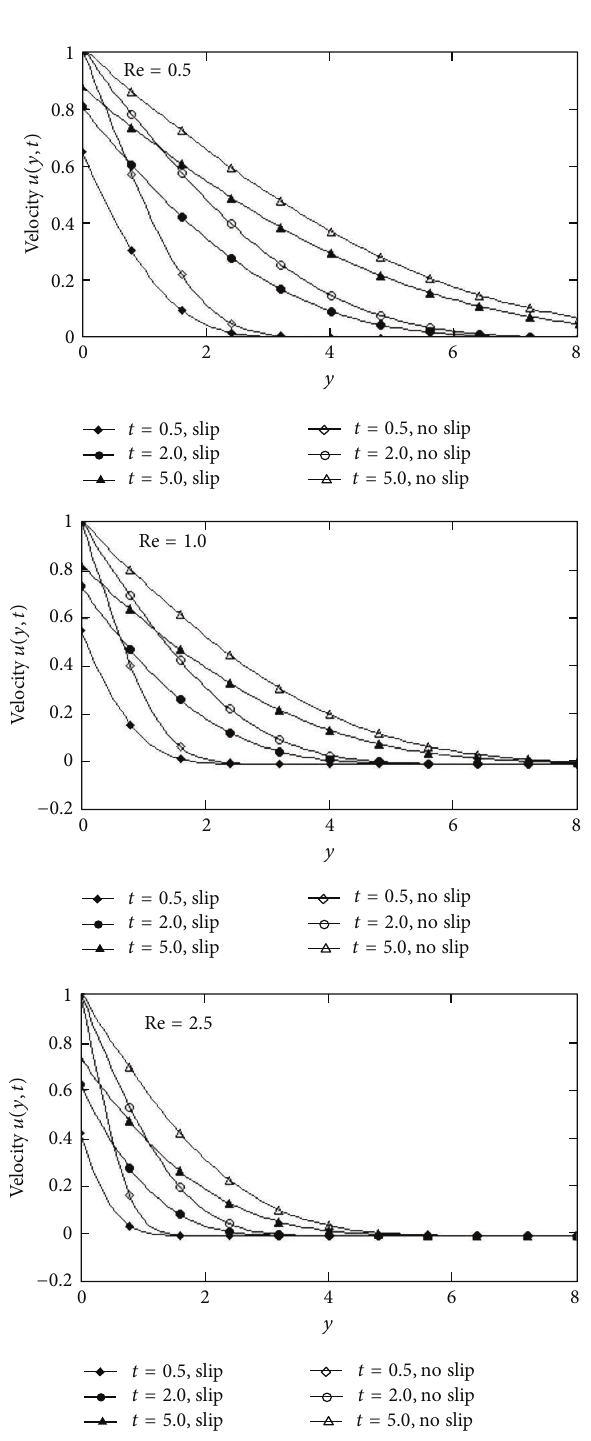
Figure 2: Velocity profiles of Oldroyd-B fluid for slip condition (16) with 𝛽 = 0.75 and no-slip condition (20) for 𝜆 = 0.25 , 𝜆 𝑟 = 0.15 , and different values of the time 𝑡